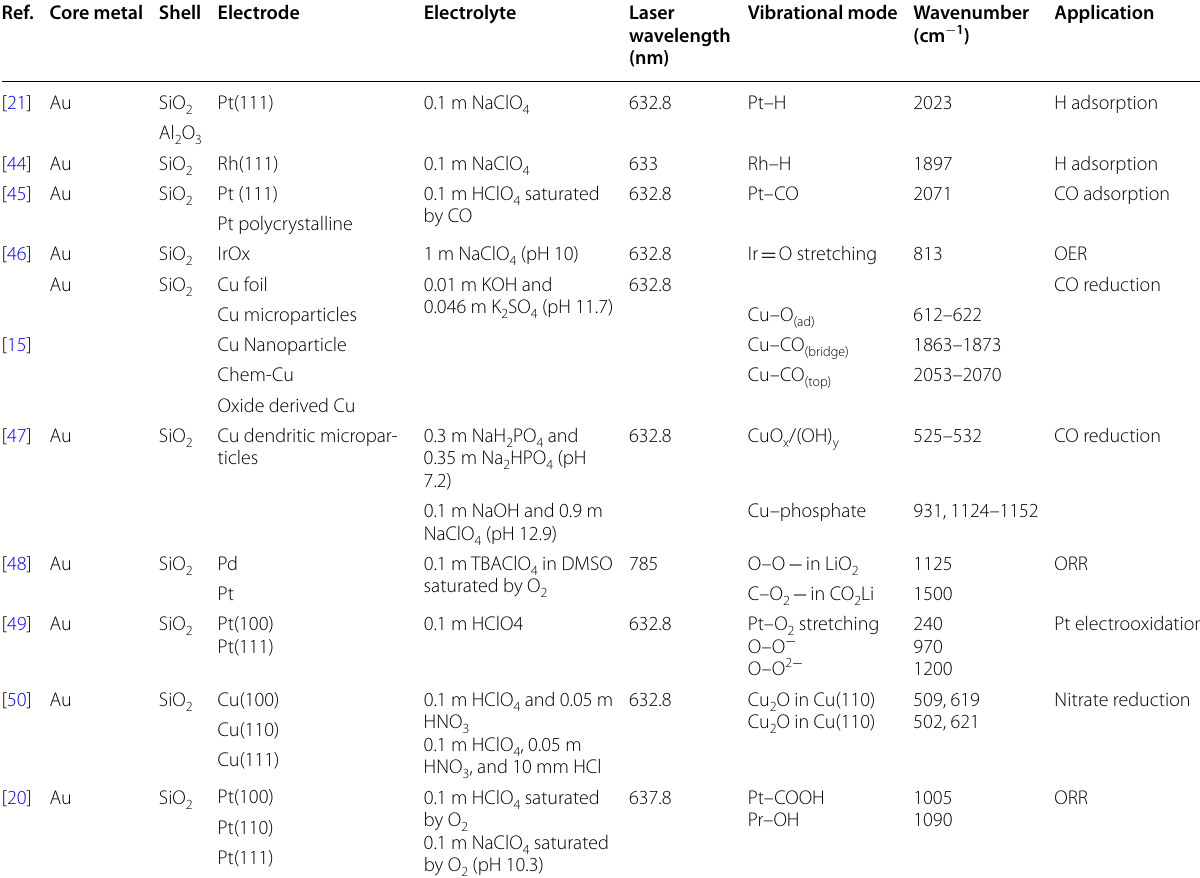
Table 1 Summary of reported applications and experimental conditions of SHINERS for electrocatalyst Ref. Core metal Shell